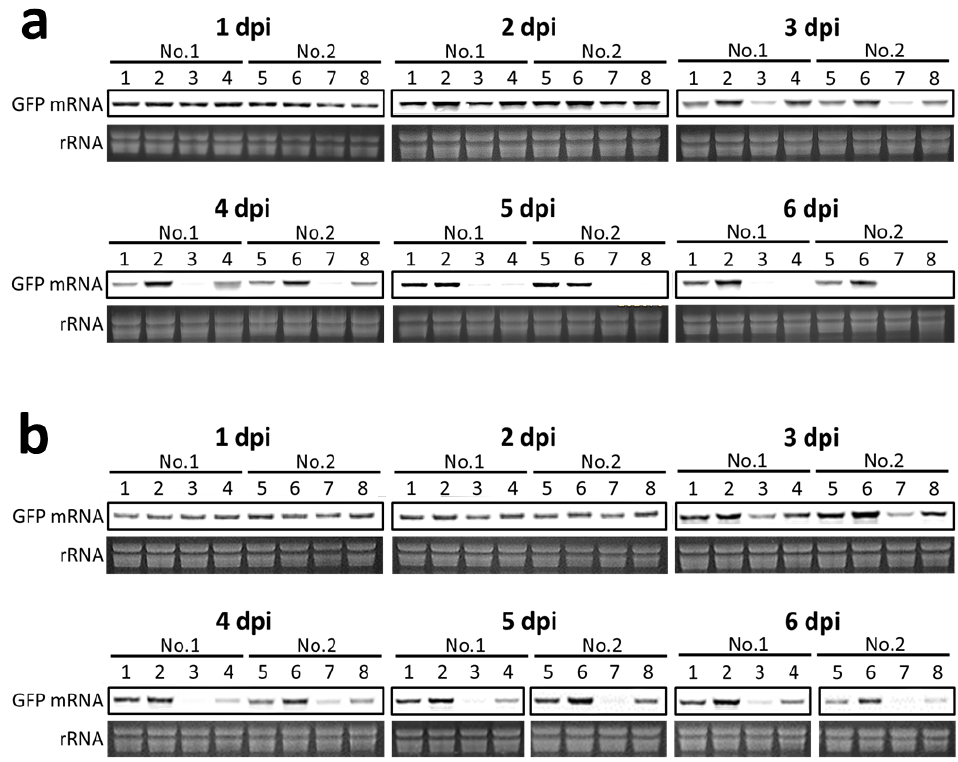
Figure 2. Northern blot assay of GFP mRNA accumulation. High molecular weight (HMW) RNA was isolated from infiltrated areas from two leaves at 1~6 days post-infiltration and subjected to northern blot hybridization analysis. rRNAs are shown as loading controls. ( a ) Analysis of GFP mRNA in non-infiltrated tissues (lanes 1 and 5) and tissues infiltrated with empty vector (lanes 2 and 6), or co-infiltrated with V + hpE35S (lanes 3 and 7) or hpE35S + Rep (lanes 4 and 8). ( b ) Analysis of GFP mRNA in non-infiltrated tissues (lanes 1 and 5) and tissues infiltrated with empty vector (lane 2 and 6), or co-infiltrated with V + hpE35S (lanes 3 and 7) or hpE35S + RepA (lanes 4 and 8).